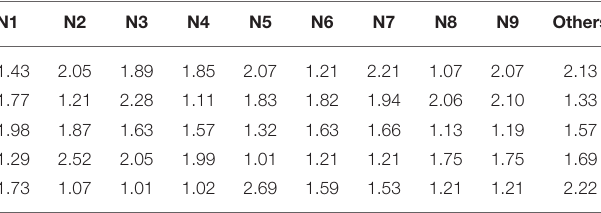
TABLE 5 | Partial results of SQL data